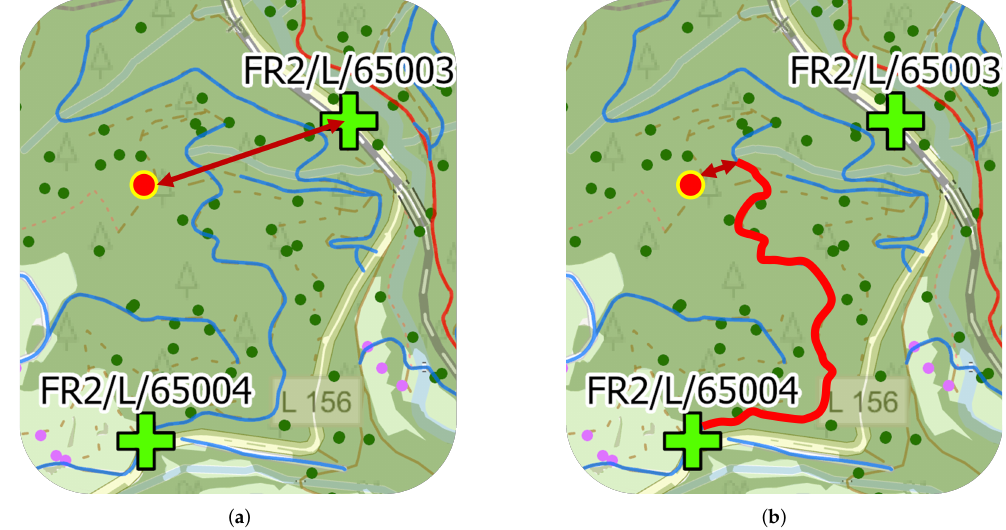
Figure 4. Illustration of the calculation method for two different distance indices: ( a ) Euclidean distance from random points to the nearest rescue point; ( b ) Euclidean distance from random points to nearest road combined with the road network distances from a road point to the nearest rescue